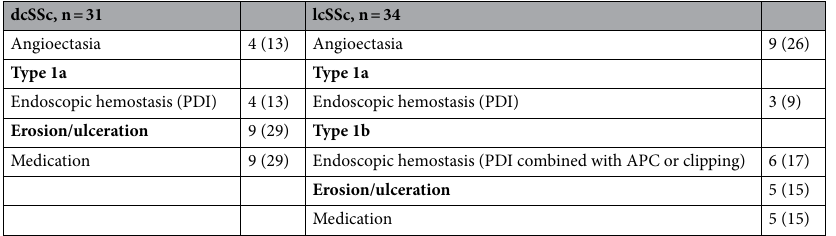
Table 3. Treatment methods for small-bowel lesions in patients with systemic sclerosis. Data are shown as frequencies (percentages) or means, as appropriate. SSc: systemic sclerosis, dcSSc: diffuse cutaneous SSc, lcSSc: limited cutaneous SSc, PDI: polidocanol injection, APC: argon plasma coagulation.